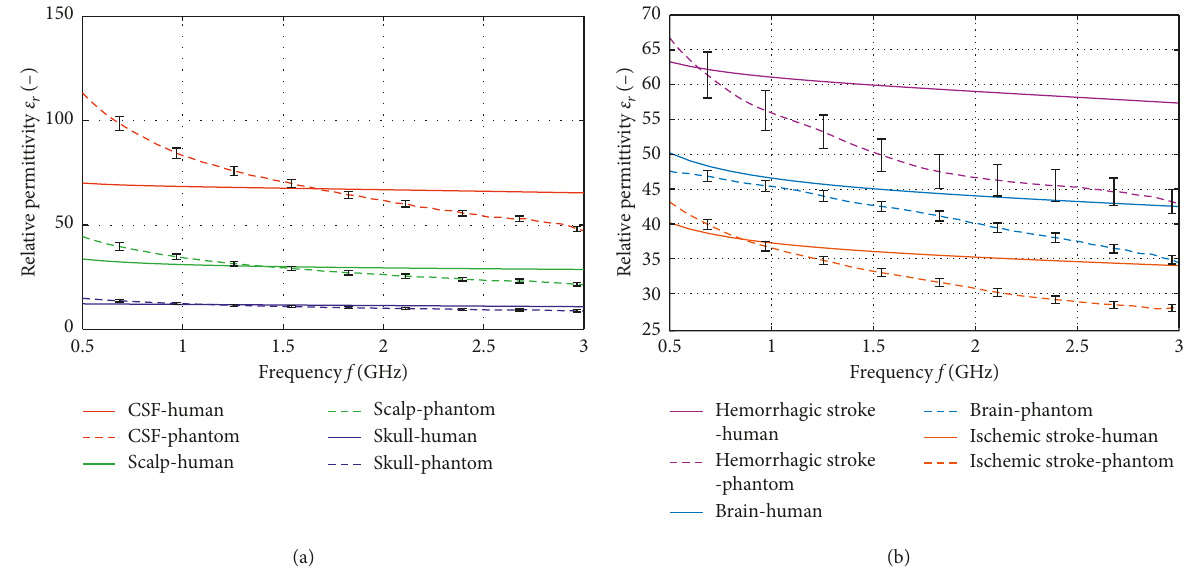
Figure 4: Frequency dependence of the human head phantom relative permittivity with extended uncertainties ( k � 2): (a) scalp, skull, and CSF solid phantom layers; (b) liquid brain and solid stroke phantom layers.